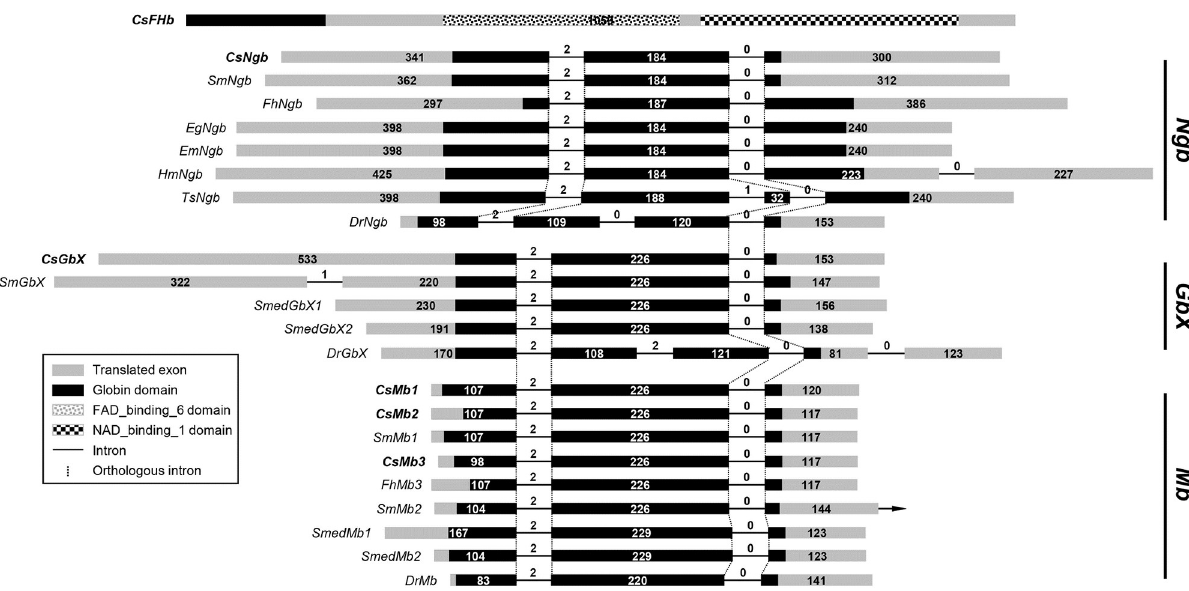
Fig 2. The exon-intron organizations of the Clonorchis sinensis globin genes. Genomic organizations of the C . sinensis genes and their orthologs were determined by comparing the genomic and transcribed sequences of the respective genes. The coding DNA sequences (CDSs) are represented with gray squares in proportion to their relative sizes and the intervening introns are indicated by solid lines with a fixed length. The phase of each intron, as well as the length of exons and introns in base pairs, is indicated in parentheses. Introns occupying orthologous positions among these genes are connected by vertical dotted lines. The positions of codons encoding functional domains, which are listed in the legend, are differentially marked in the respective CDS regions.